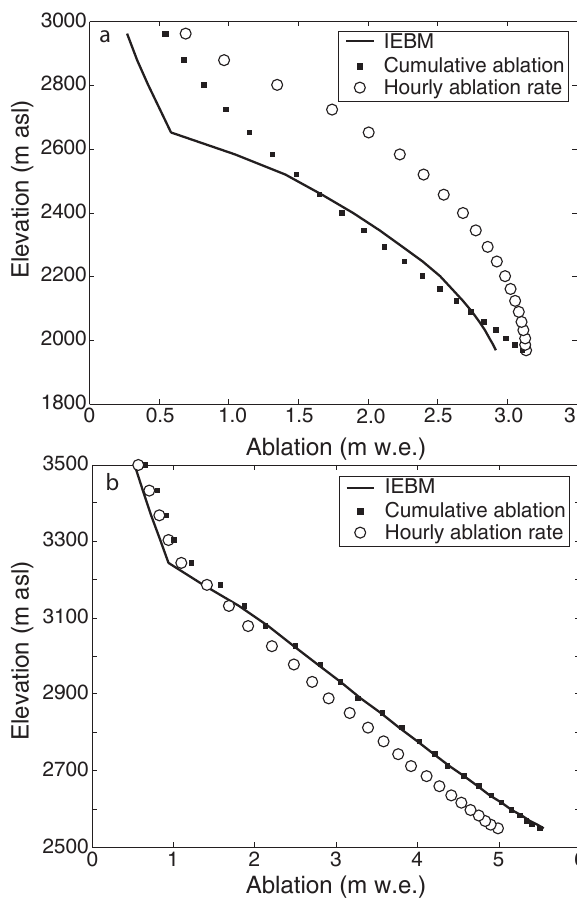
Fig. 3. Ablation as a function of elevation computed with the temperature-index model of Pellicciotti et al. (2005) tuned to both cumulative ablation and hourly ablation rates as simulated by the IEBM. The energy balance model forced with idealized inputs (IEBM) is also shown. (a) Inputs intended to represent Donjek Range glaciers (DRG in Table 4). (b) Inputs intended to represent Haut Glacier d’Arolla (HGA in Table